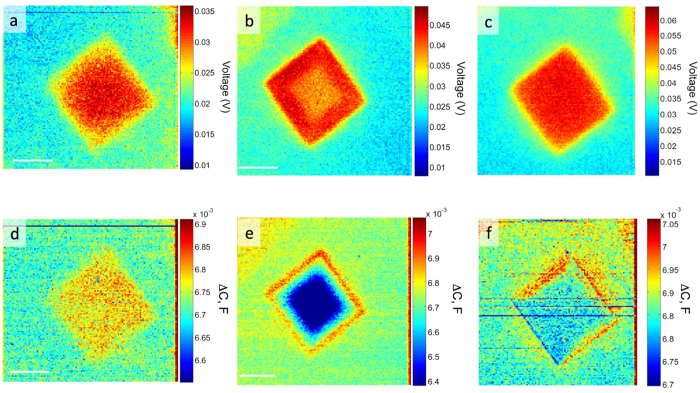
Tapping mode band excitation (BE) Kelvin probe force microscopy (KPFM) of supported MoSe2.(a–c) Local contact potential difference (LCPD) and (d–f) capacitance gradient maps of regions irradiated by He+ beam with different doses: (a,d) 1 × 1014 ions/cm2 (b,e) 1 × 1015 ions/cm2 and (c,f) 1 × 1016 ions/cm2.